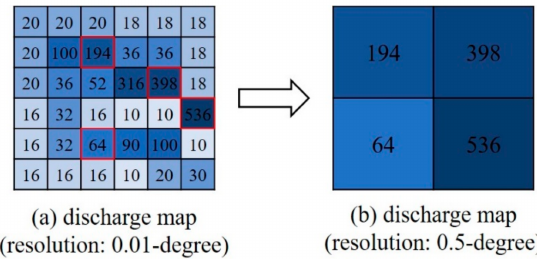
Figure 4. The procedure for resampling the spatial resolution of the global river discharge map from ( a ) 0.01 degrees to ( b ) 0.5